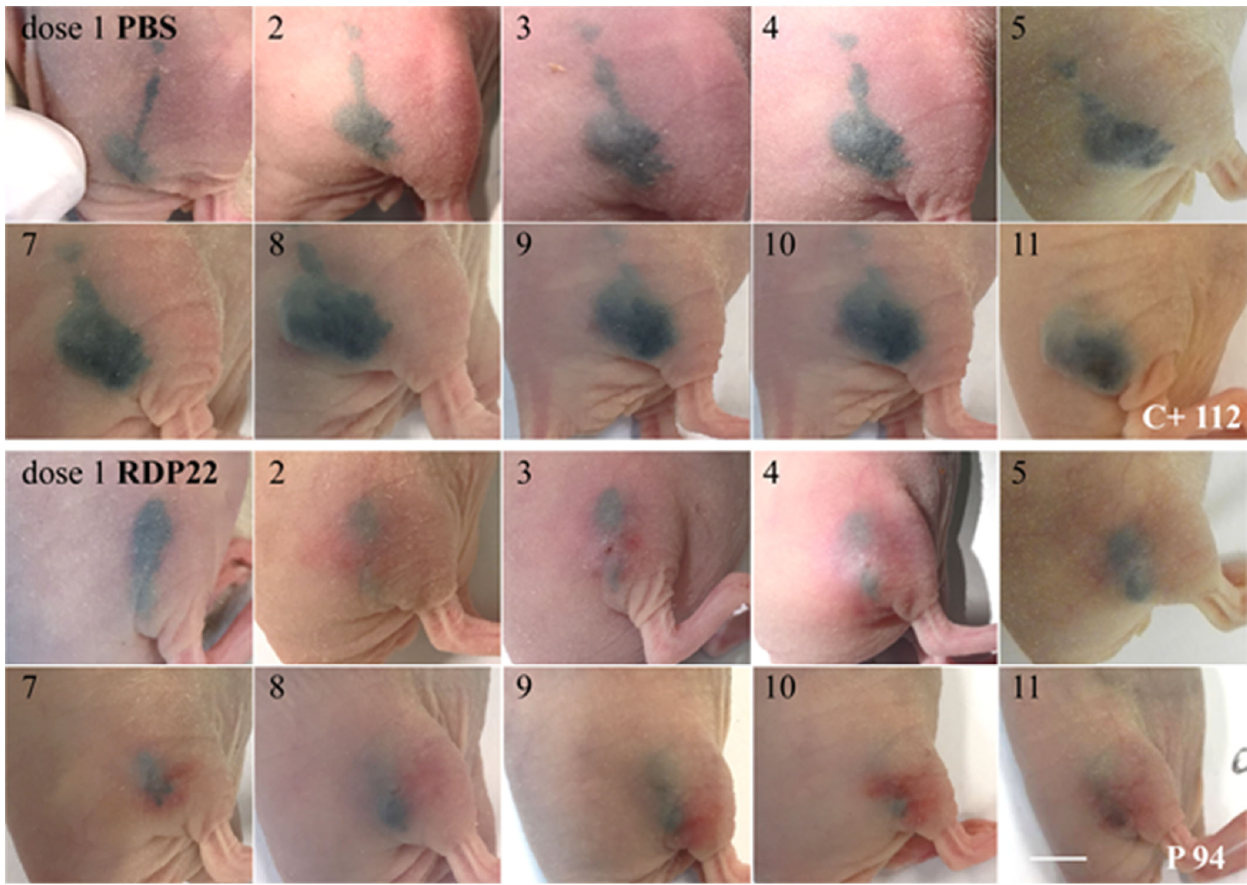
Figure 8. The melanogenic cell line MUG ‐ Mel2 [22] was xenotransplanted subcutaneously in the right flank of FOXN1 mice C+ 112 (control PBS) and P 94 (peptide treatment). Before treatment, the tumors were grown to an approximate area of 20–25 mm 2 . Top rows: Representative control mouse C+ 112 was injected intratumorally with 100 μ L buffer PBS 11 times within 14 days. Numbers indi ‐ cate doses injected. Tumor growth of MUG ‐ Mel2 is clearly visible due to intense pigmentation of the melanoma cells. Bottom rows: Representative peptide ‐ treated mouse P 94 ( n = 8) was injected intratumorally with 11 peptide doses of RDP22 of 0.2 mg, each. A total peptide amount of 2.2 mg RDP22 was used. A clear killing of MUG ‐ Mel2 cells is observable upon peptide treatment by the strong reduction in the pigmented tumor cells. Respective doses are elevated. The bar represents 0.5 cm.